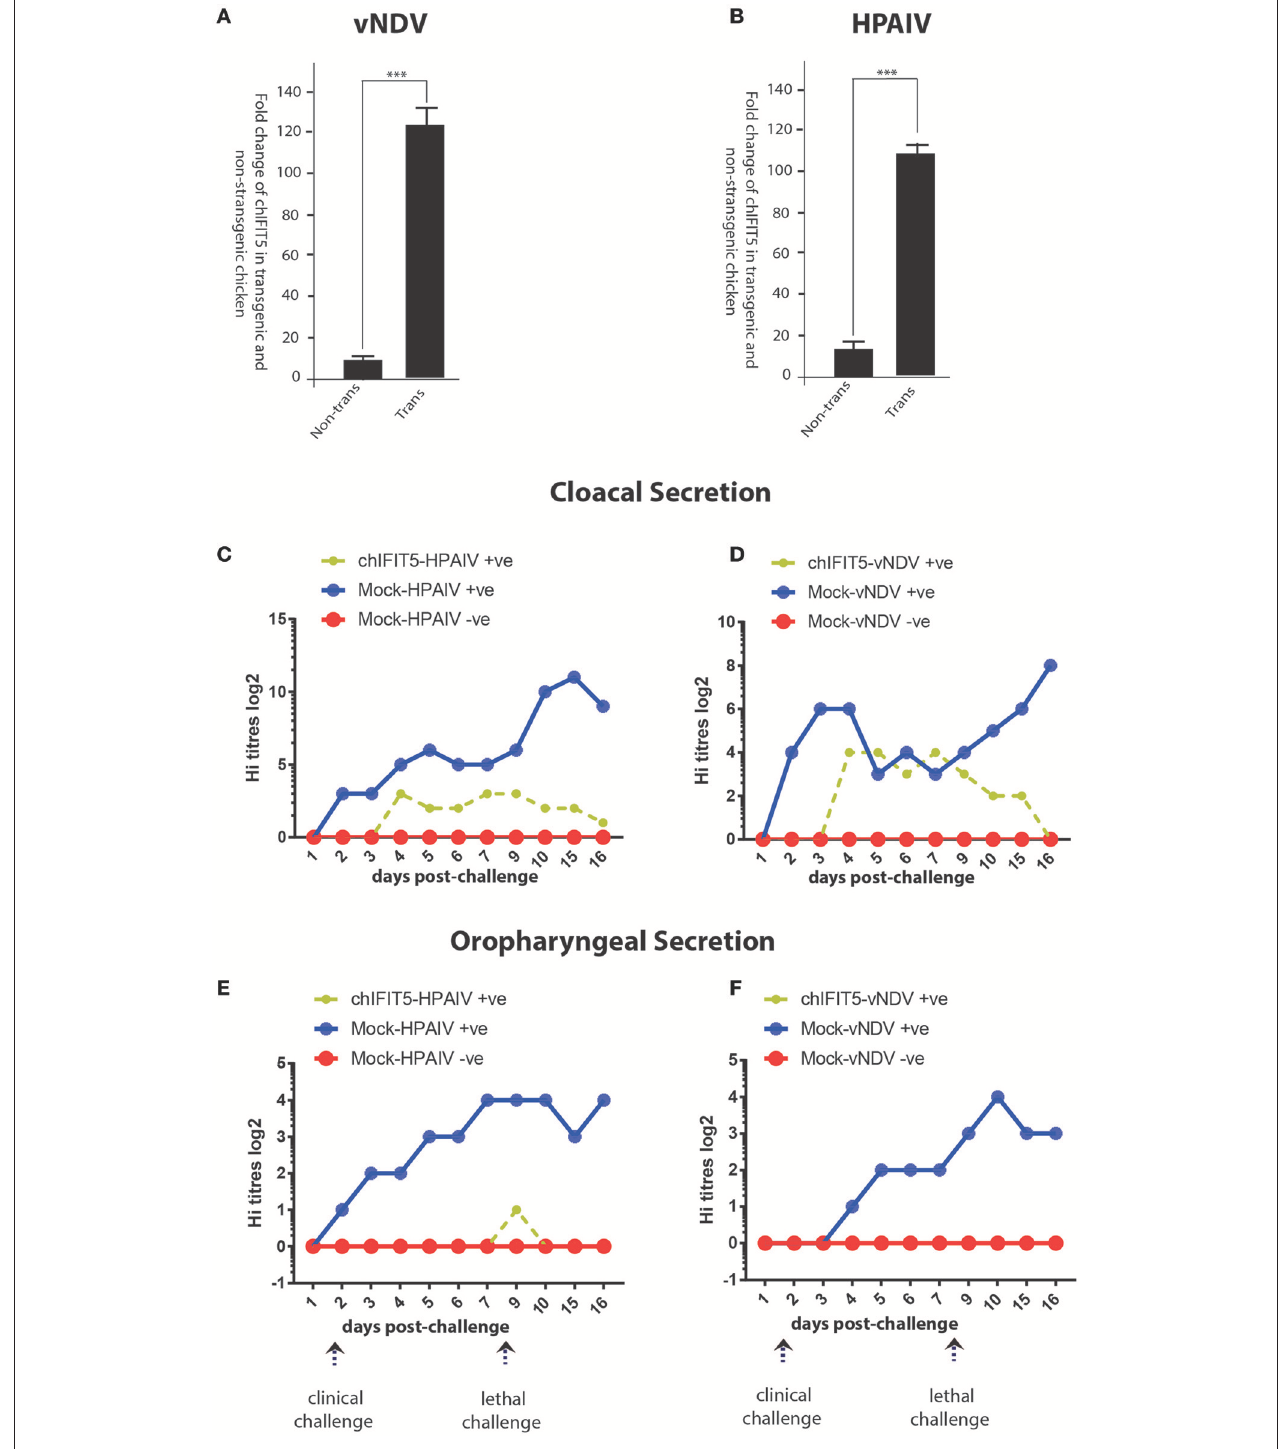
FIGURE 6 | Expression of the transgene (chIFIT5), in vNDV-infected transgenic (A) and HPAIV-infected transgenic (B) , compared to non-transgenic chicken. Quantitative assessment of virus shedding in cloacal section for the (C) vNDV, (D) HPAIV and in oropharyngeal secretion for the (E) vNDV and (F) HPAIV in transgenic chickens expressing chIFIT5-challenged with virus (chIFIT5-vNDV/HPAIV + ve), mock-transgenic-virus challenged (mock-vNDV/HPAIV + ve) and mock control (mock-vNDV/HPAIV –ve). Days of clinical and lethal challenges are marked with arrows. *** indicate the level of significance at p > 0.05.